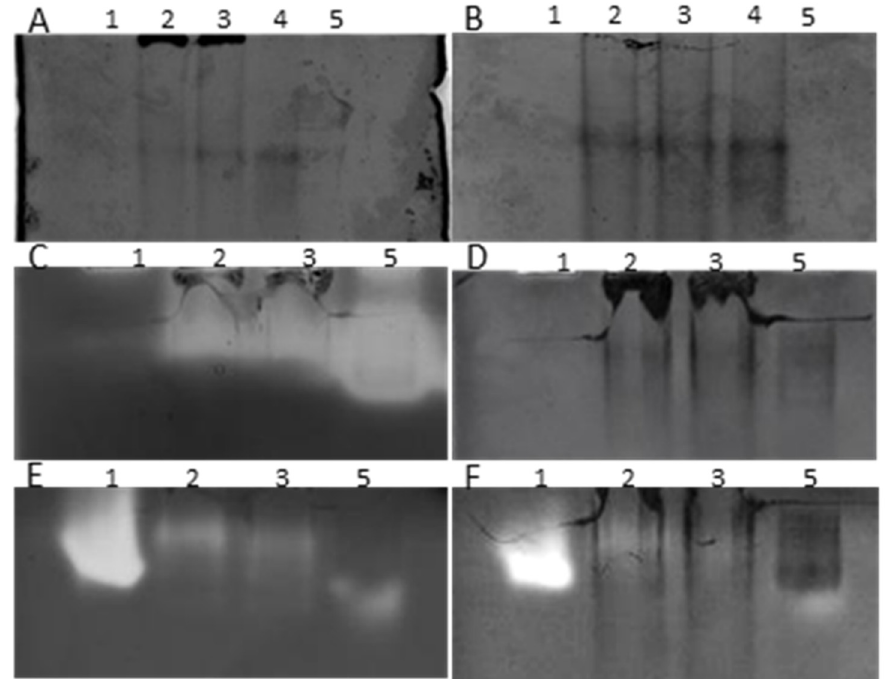
Figure 3. Optimization of in-gel GPX assay. ( A ) GPX reaction mixture with 0.008% cumene hydroperoxide and without GSH showing no achromatic bands. ( B ) As in A, in the presence of 10 mM sodium azide. ( C ) GPX reaction with 1 mM GSH, 0.01% hydrogen peroxide, showing high activity in all samples except lane 1, bovine GPX standard. ( D ) same as ( C ) in the presence of sodium azide, confirming that the activity in C is almost entirely due to catalase. ( E ) GPX reaction with CHP showing intrinsic GPX activity also for the standard bovine catalase. ( F ) Same as E with sodium azide showing residual activity in all samples. The dark bands represent artifacts of the staining procedure that do not interfere in the analyses. Legend: Lane 1, commercial bovine liver GPX standard (150 mU); 2, gill SN20 (100 μ g); 3, 4 digestive gland SN20 (100 μ g); 5, commercial bovine liver catalase standard (10 U).